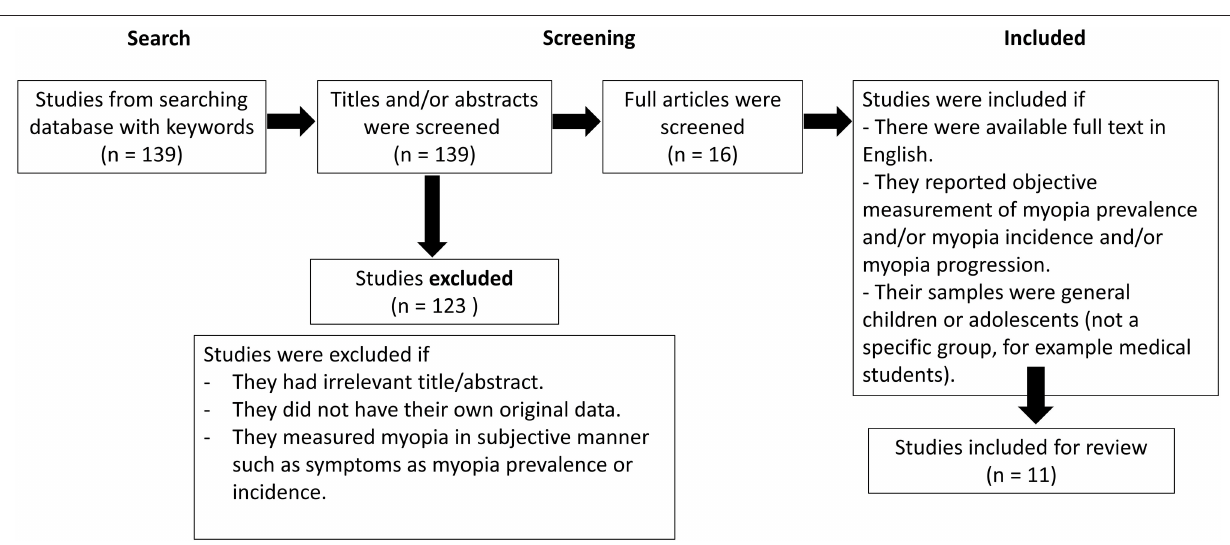
FIGURE 2 | Search and selection strategies of the changes in myopia during the COVID-19